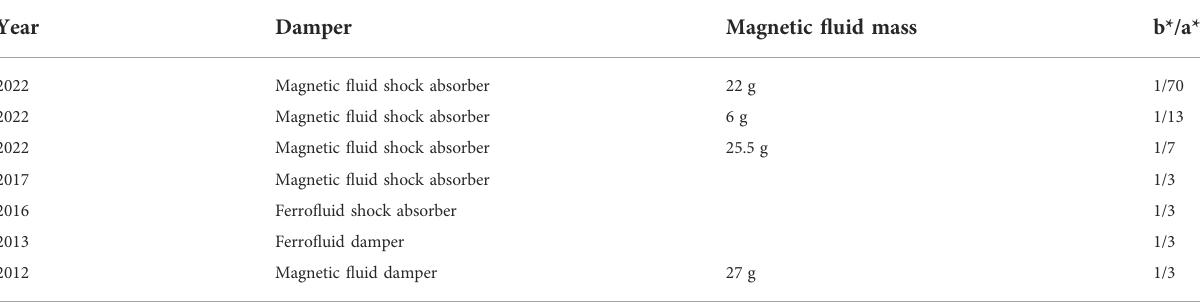
TABLE 2 Comparison of the optimal magnetic fl uid shock